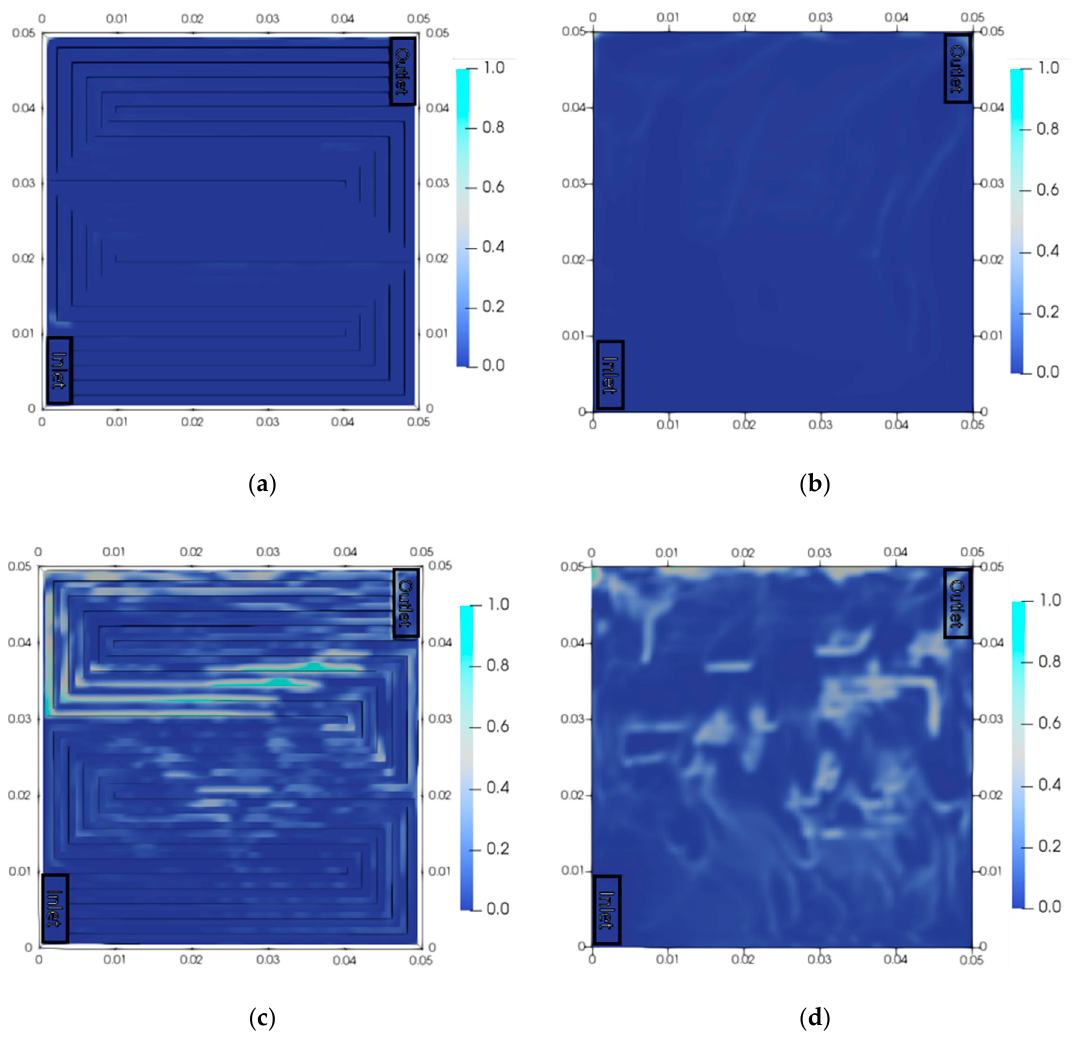
Figure 7. Volume fraction of oxygen ( a ) in the channel and ( b ) in the PTL at 1000 A / m 2 , and ( c ) in the channel and ( d ) in the PTL at 20,000 A / m 2 .